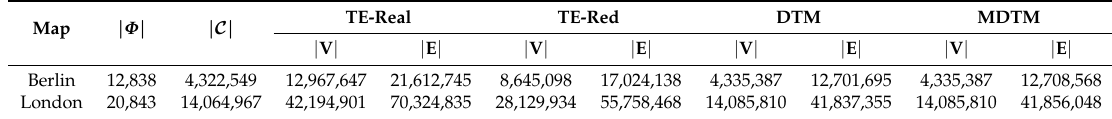
Table 2. Tested timetables and sizes of the corresponding graphs.